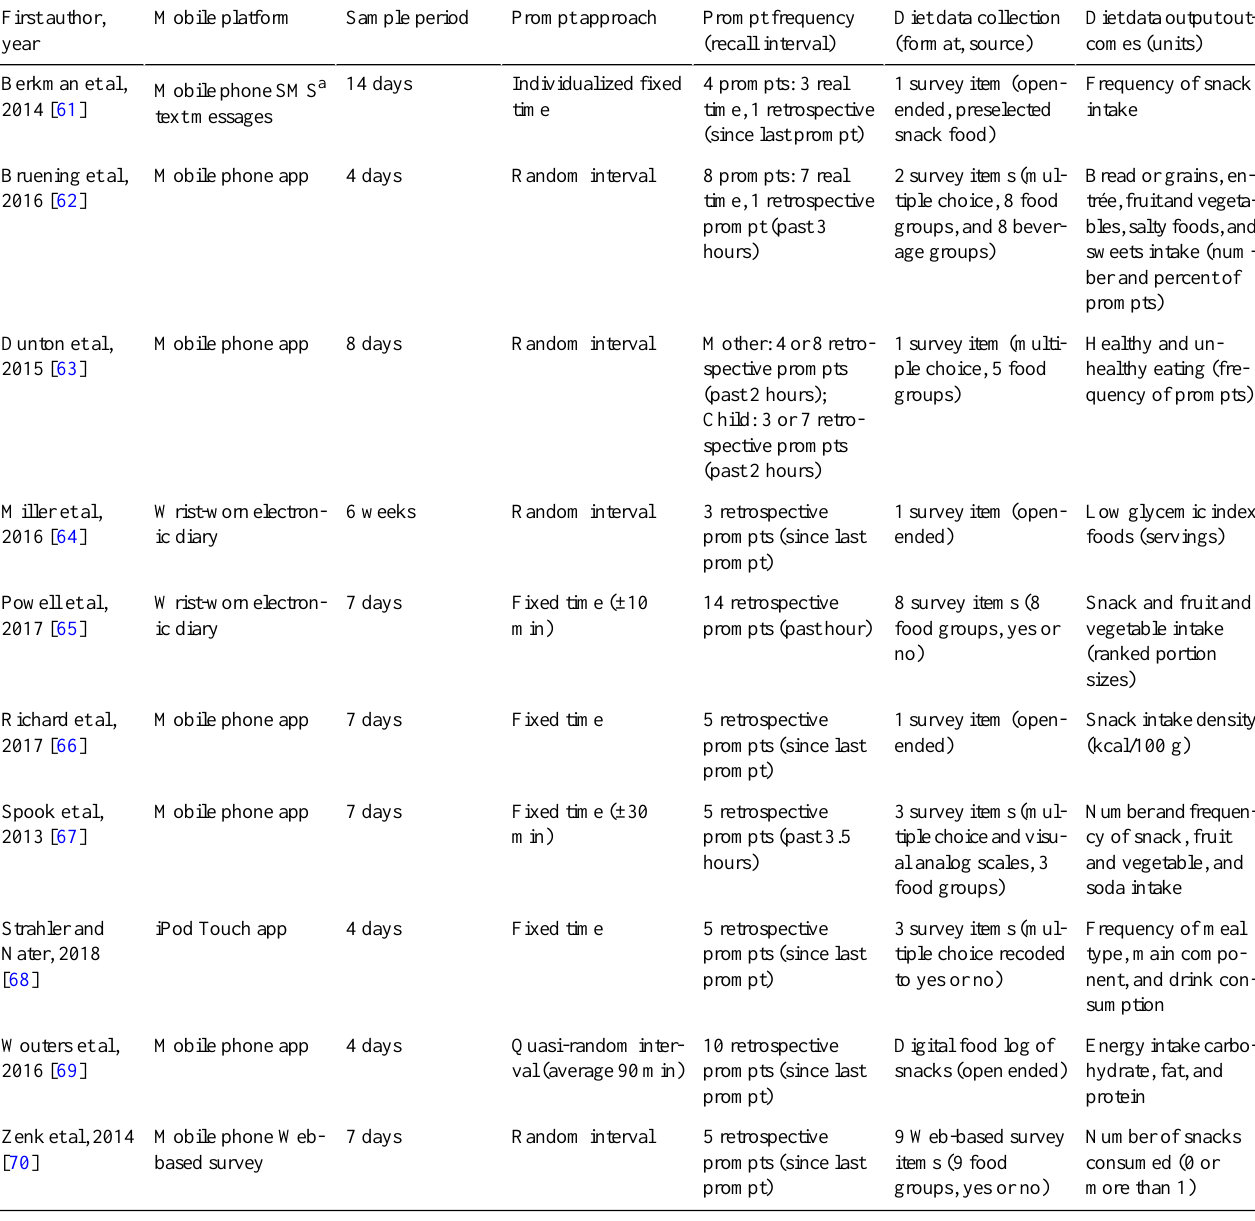
Table 2. Signal-contingent, mobile ecological momentary dietary assessment.